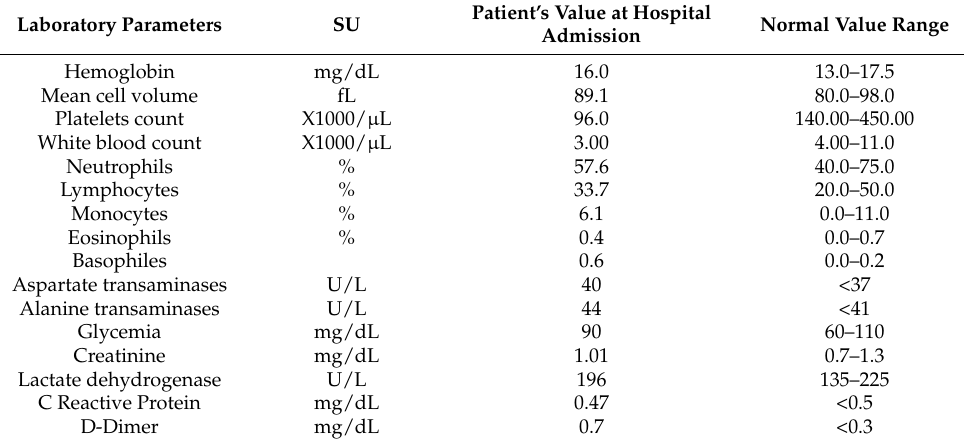
Table 1. Main laboratory analyses result with the reporting systemic unit (SU) of measurements at the hospital admission and the normal value